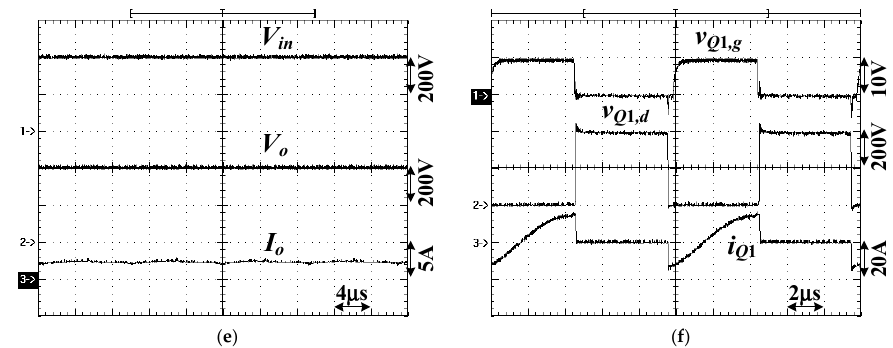
Figure 11. Experimental results at V in = 400 V (high voltage range) and 1 kW load. (a) v Q 1, g ~ v Q 4, g, (b)